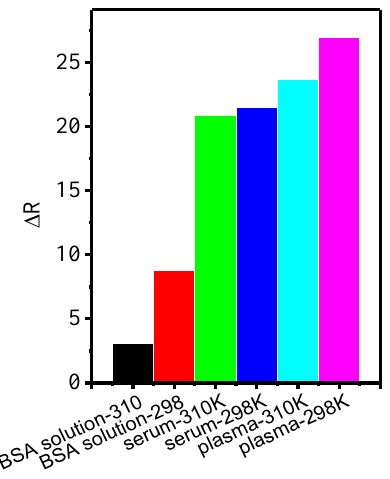
Figure 5. Protein corona thickness of quantum dots in plasma, serum, and BSA solution at different temperatures (298 and 310 K).